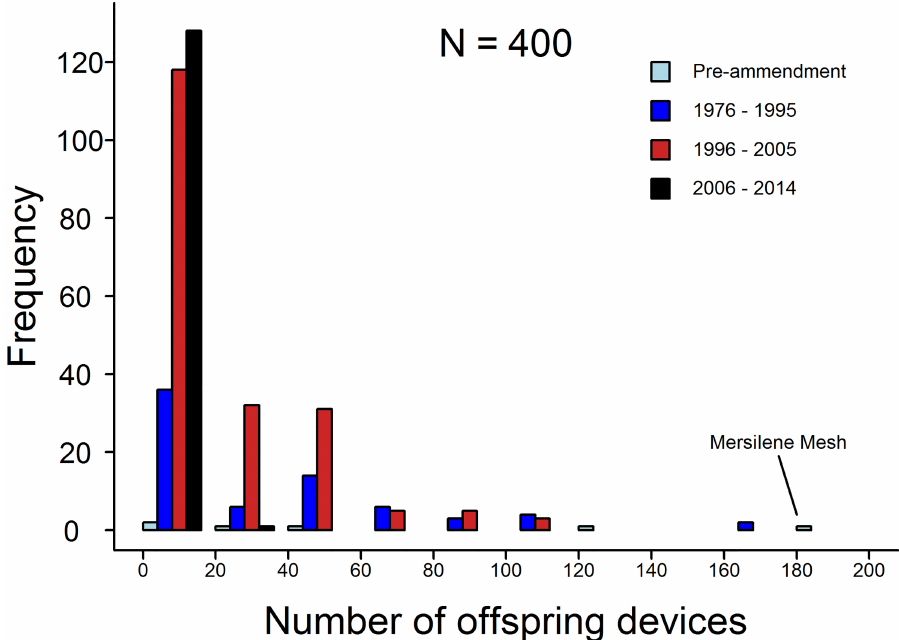
Fig 2. The total number of descendent devices connected to each ancestral predicate (n = 400) by chains of substantial equivalency. Ancestral predicates are grouped according to the time period in which they entered the market (bar color) to highlight that the skewed distribution in the number of descendent devices is not an artefact of the time available for ancestral predicates to accumulate descendants. Mersilene Surgical Mesh had the largest number of descendent devices and is highlighted (see Fig 3 for the ancestral history of this